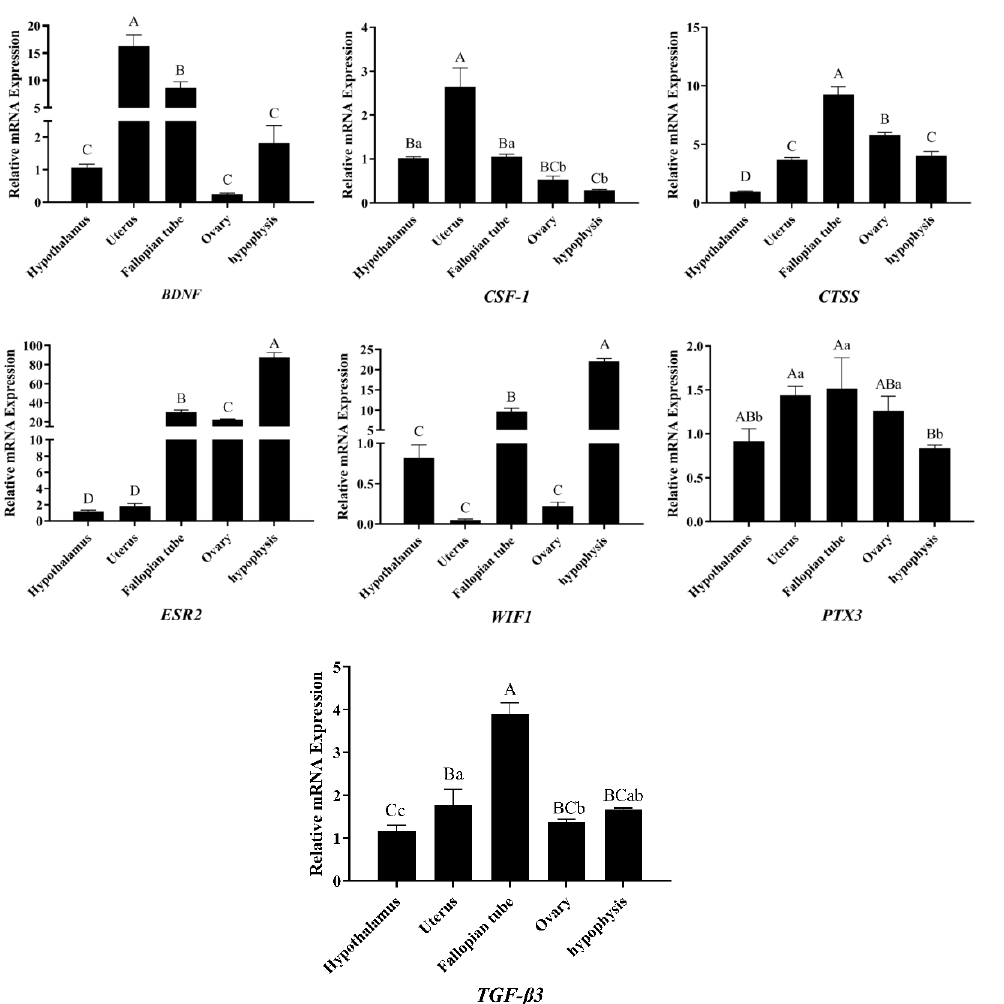
Figure 7. Differential gene expression patterns in the gonadal axis tissue of the Qianbei Ma goats. Different capital letters A, B, C and D indicate highly significant differences in expression levels between different tissues ( p < 0.01) and different lower case letters a, b and c indicate significant differences in expression levels between different tissues ( p < 0.05).